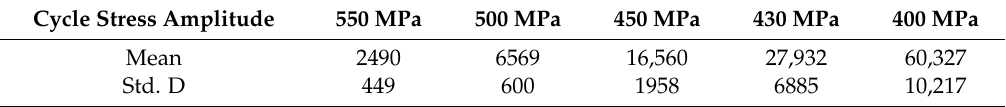
Table 5. Mean and standard deviations of fatigue life of the first group (tempering temperature 700 ◦ C).